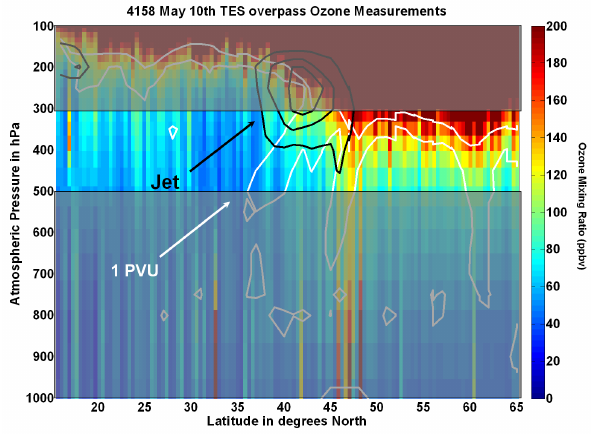
Fig. 2. Plot of TES “Step and Stare” ozone profile curtain for 10 May 2006, in which the ozone volume mixing ratio (VMR) is plot- ted in color shading (ppbv). The location of the jet stream (black contours) and of the 1 and 3 PV-unit contours (white) are also plot- ted to show the dynamical context (both from GFS model). The vertical extent of layer-averaging for TES ozone and GFS PV is designated by the black outline (500 to